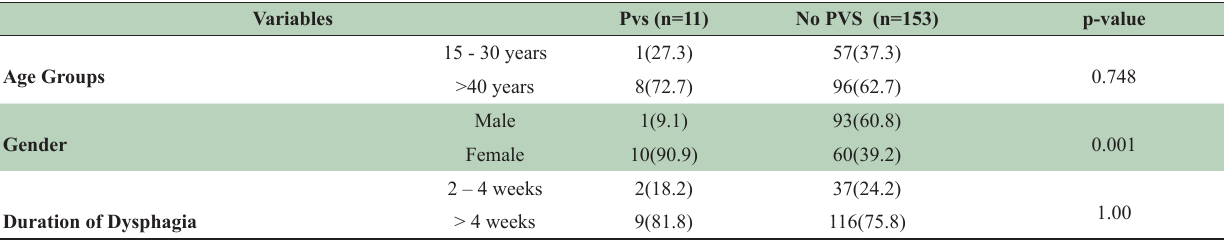
Table-II: Association of Plummer Vinson Syndrome with age, gender and duration of